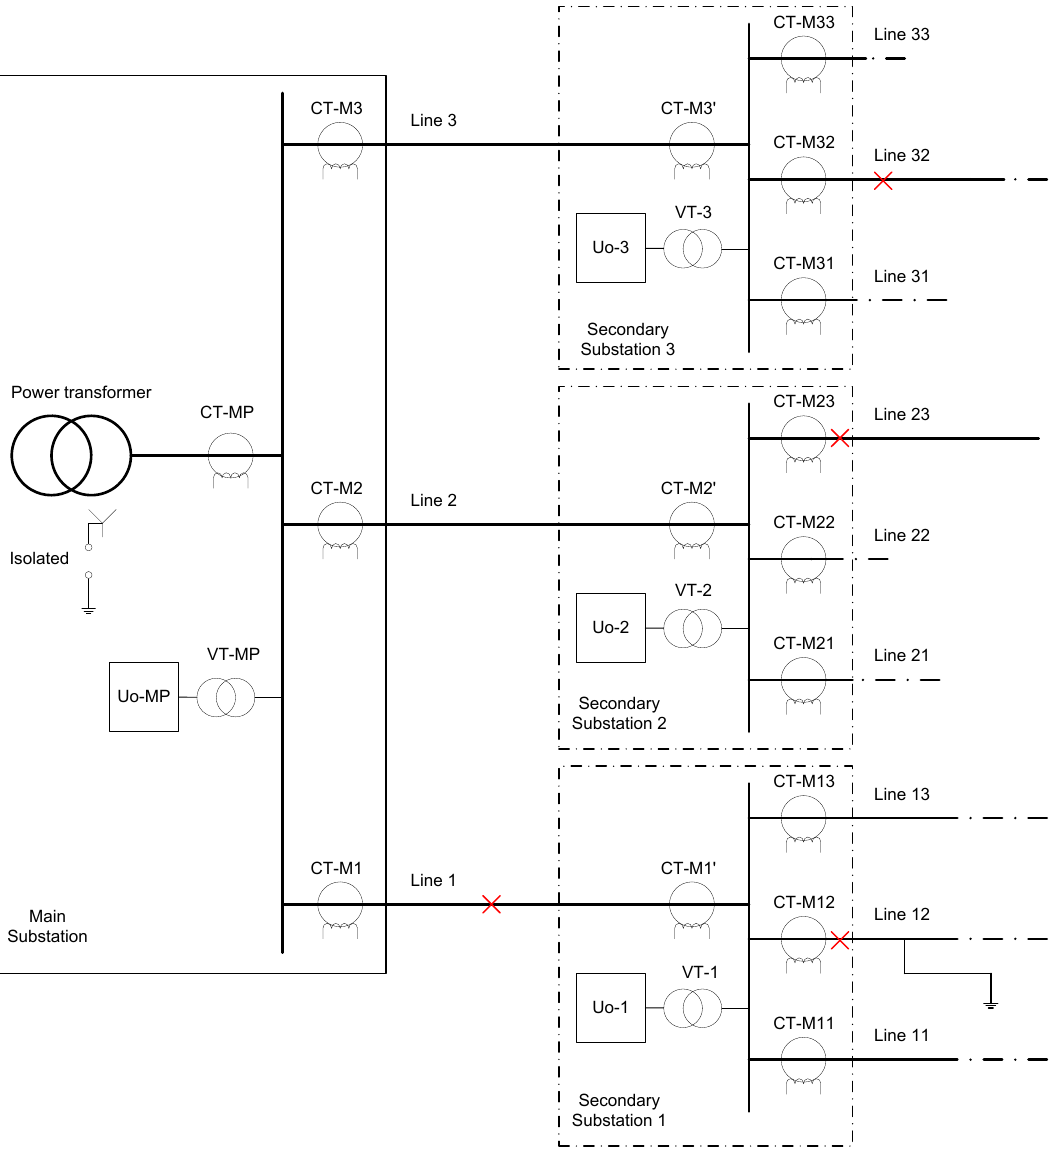
Figure 7. Highest ground fault currents at isolated network with secondary substations. Ground fault at Line